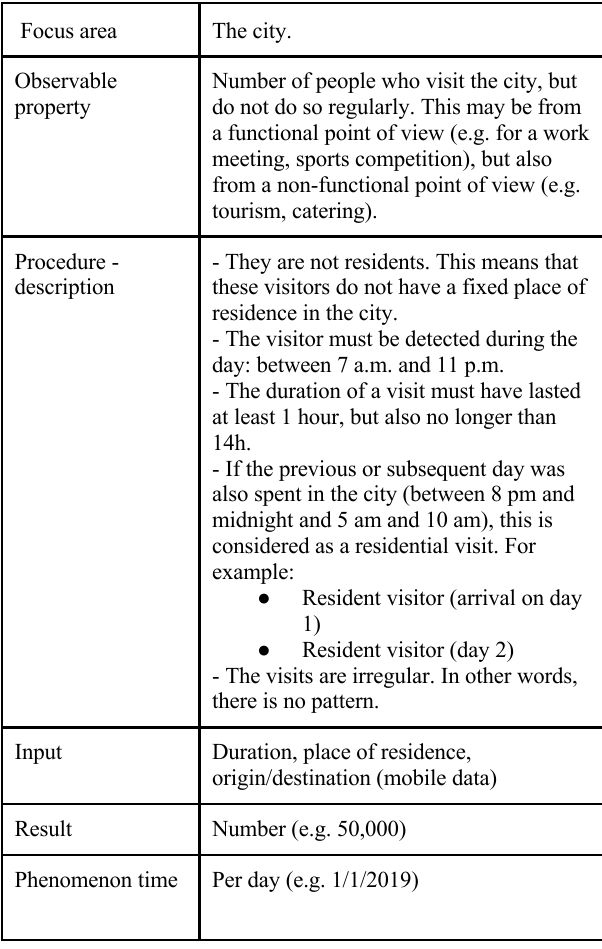
Table 4. Description of the profile “Random day visitor”.